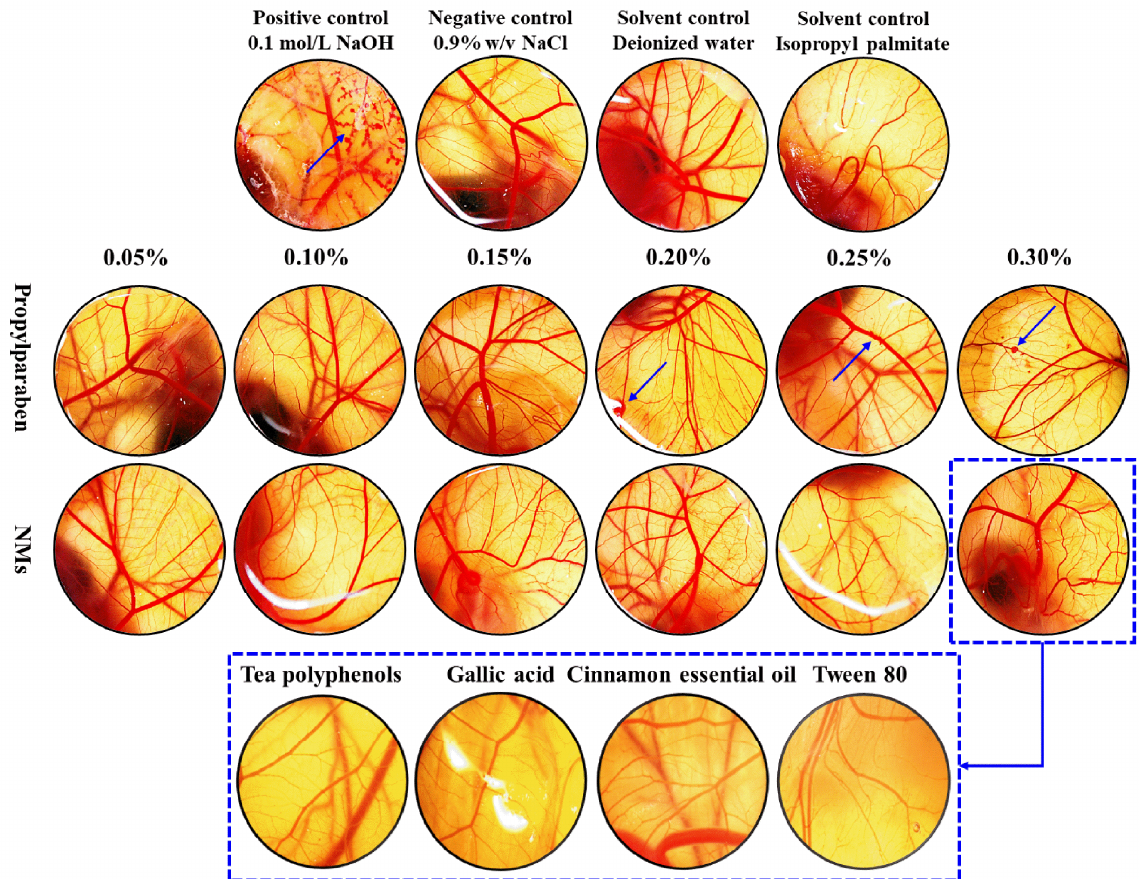
Figure 4. The results of HET-CAM. Effect of positive control (0.1 mol/L NaOH), negative control (0.9% w/v NaCl), solvent control (deionized and isopropyl palmitate), PP solution, and NMs, which were composed of deionized water and isopropyl palmitate, on the chorioallantoic membrane after 5 min. Blue arrows indicate positive control.